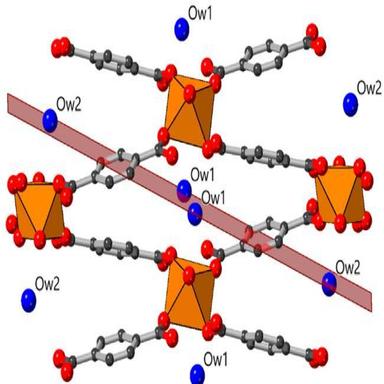
Structure of Phase 3, showing the H2O molecules (Ow1 and Ox2) and the plane (1,2,0).